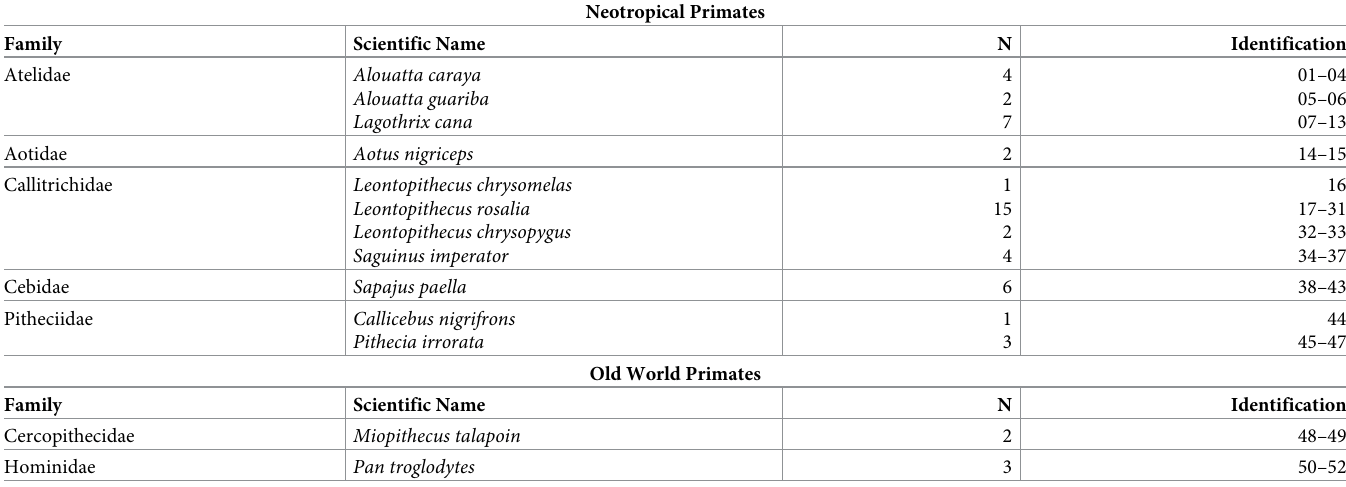
Table 1. Species of non-human primates kept at FZB-BH and included at present study.